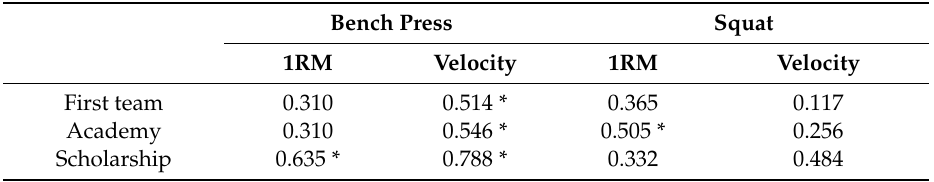
Table 3. Partial correlations for velocity (controlling for 1RM) and 1RM (controlling for velocity) with optimal power. Bench Press